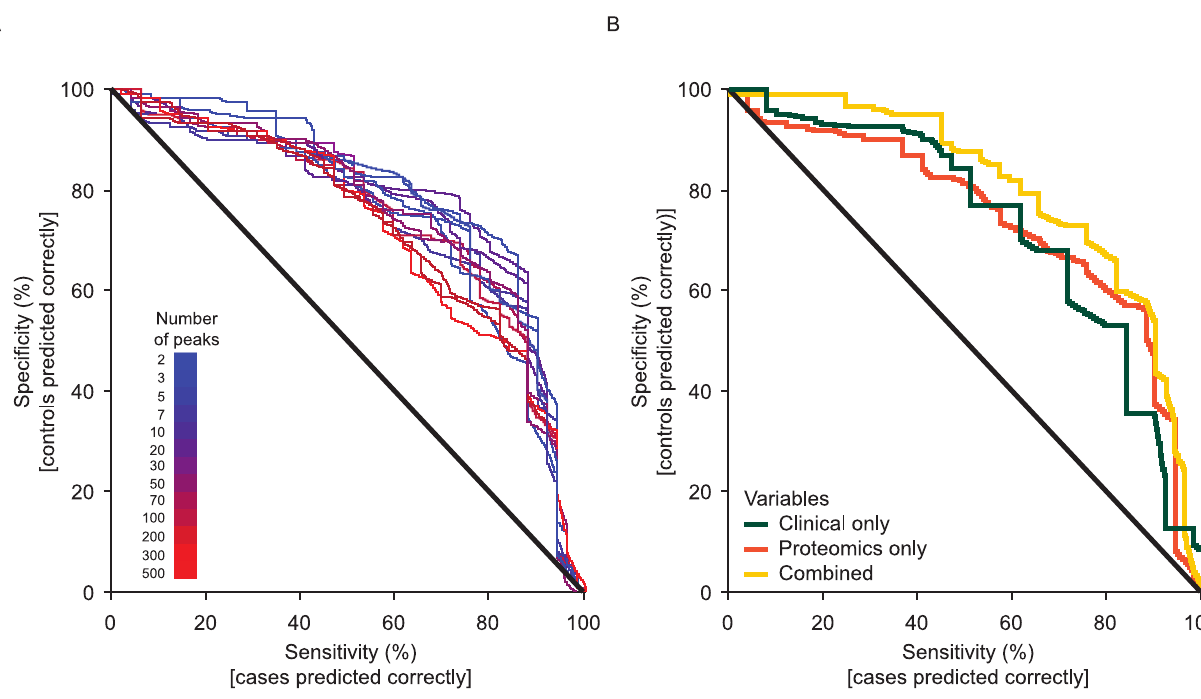
Figure 6. Receiver operating characteristics curve of cross-validated predictions. (A) from peptides, for different number of peptides included in the proteomic prediction model, and (B) from clinical data, proteomic data, and a combination of both clinical and proteomic data.